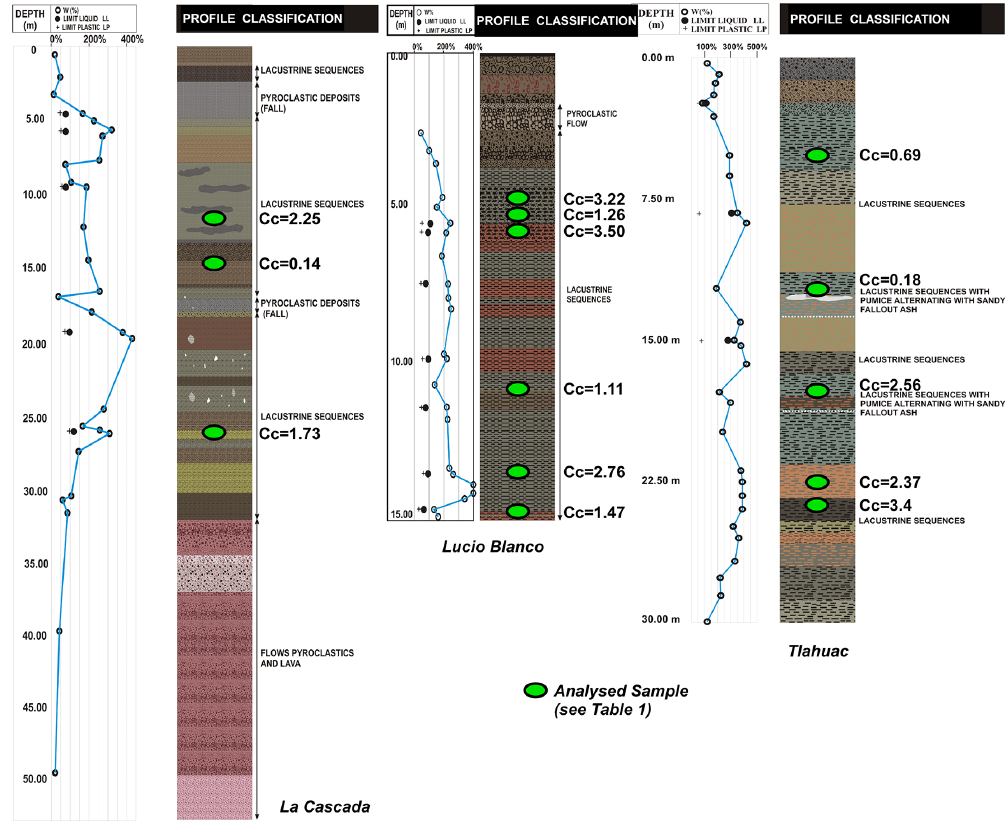
Figure 2. Lithological correlation of three fluvio-lacustrine and volcanic sequences in the Iztapalpa (La Cascada and Lucio Blanco) and Tlahuac sub-basins, obtained from geotechnical boreholes. Green ellipses indicate the location in depth of non-altered samples used for physical and mechanical characterization (see Fig. 1 for